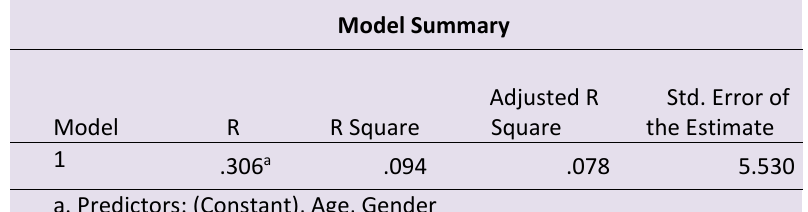
Table 6. Simple Regression Test Results X₂ and Y Model